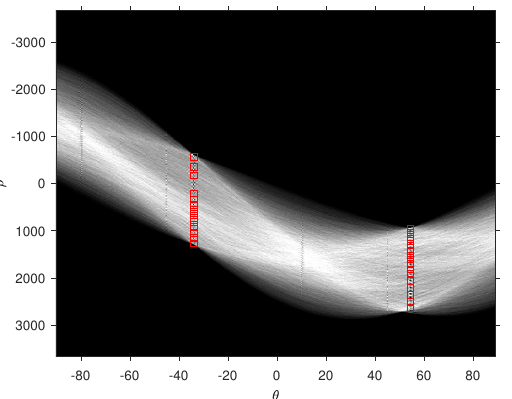
Figure 6. 30 Hough peaks corresponding to θ r = − 34° and θ c = 54.5° . The most frequent negative θ angle is θ r = − 34° and the most frequent positive θ angle is θ c = 54.5° yielding α r = 56°, α c = 35.5° and γ c = 54.5°. α r is the angle by which the BW image must be rotated clockwise around its center for the rows of vines to be horizontal. The resulting obtained image is denoted BW r . γ c is the angle by which the BW image must be rotated clockwise around its center for the columns of vines to be vertical. The obtained image is denoted BW c . Figure 7 shows the binary image of Parcel 59B overlayed with lines relative to θ r and θ c angles.